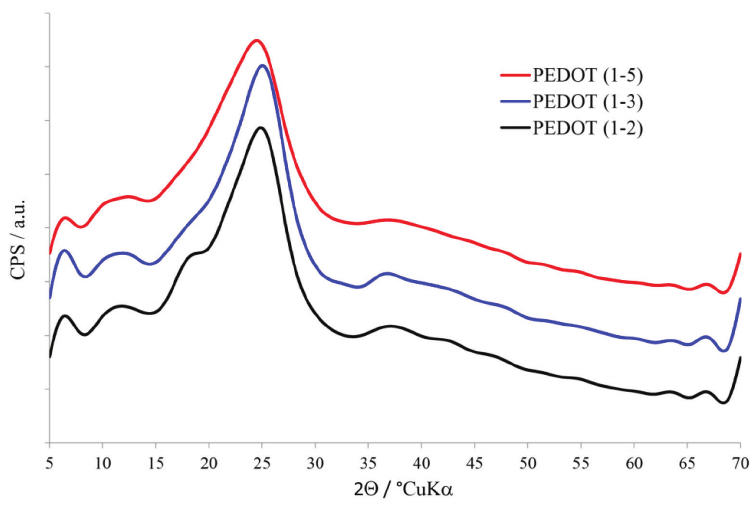
Fig. 7 – XRD diffractograms of PEDOT/ZnO samples synthesized at various monomer to APS oxidant ratio (1:2, 1:3, 1:5)